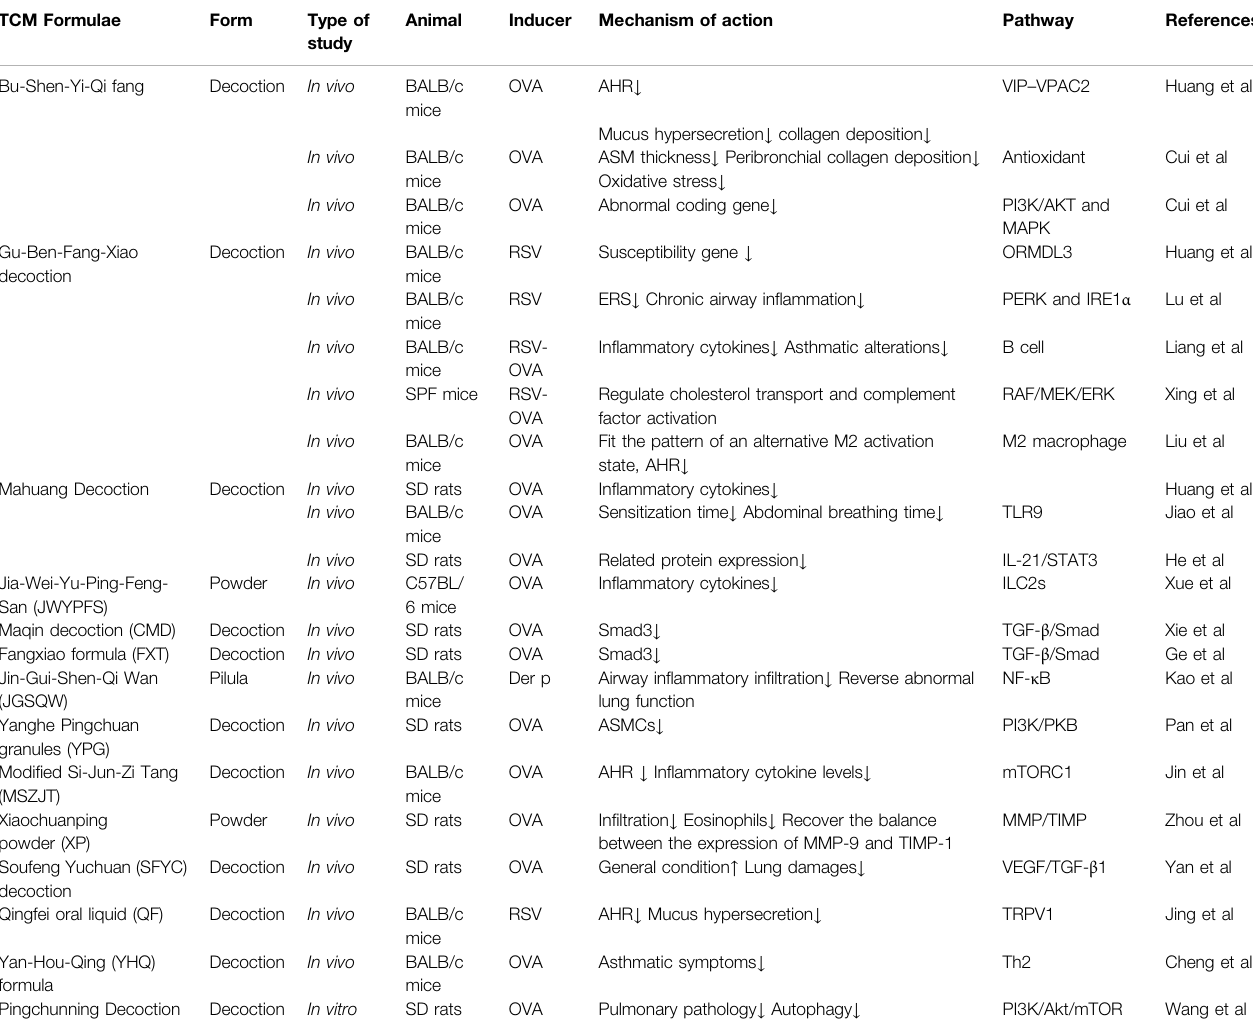
TABLE 1 | Associated TCM formulae in inhibiting in fl ammation and remodeling. TCM